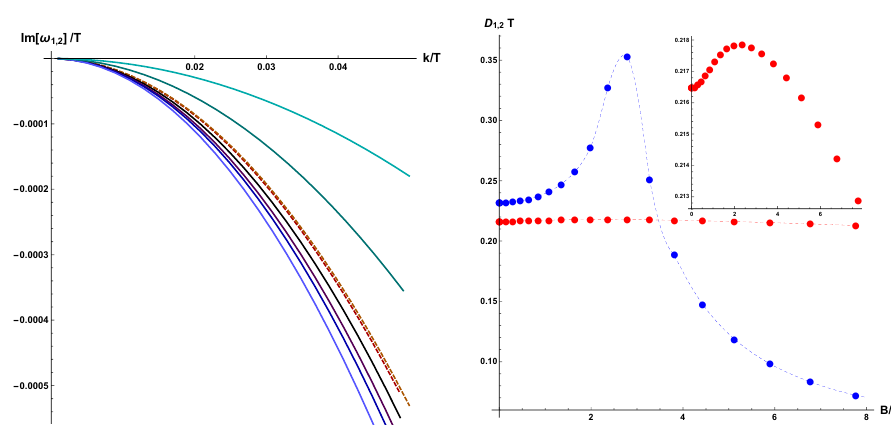
Figure 15 . The dynamics of the coupled charge and crystal di(cid:11)usive modes increasing the magnetic (cid:12)eld B . We (cid:12)x (cid:22)=T = 1 and m=T = 1 moving B=T 2 2 [0 ; 8]. Left: The dispersion relation increasing B=T 2 . The (cid:12)rst mode is displayed with dashed lines and it moves from red ! orange. The second mode is shown with (cid:12)lled lines and it moves from black ! blue ! light blue. Right: The di(cid:11)usion constants as a function of the magnetic (cid:12)eld B . The red dots correspond to the mode displayed with dashed lines in the left panel, and the blue dots to the (cid:12)lled lines.